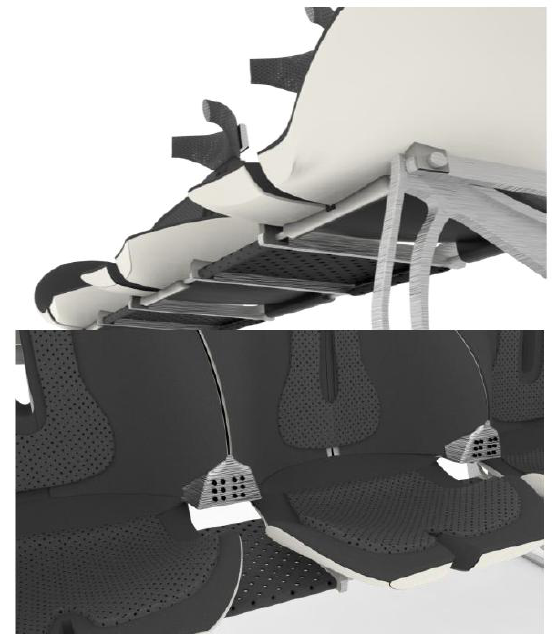
Figure 44. Seat cushion of final product.